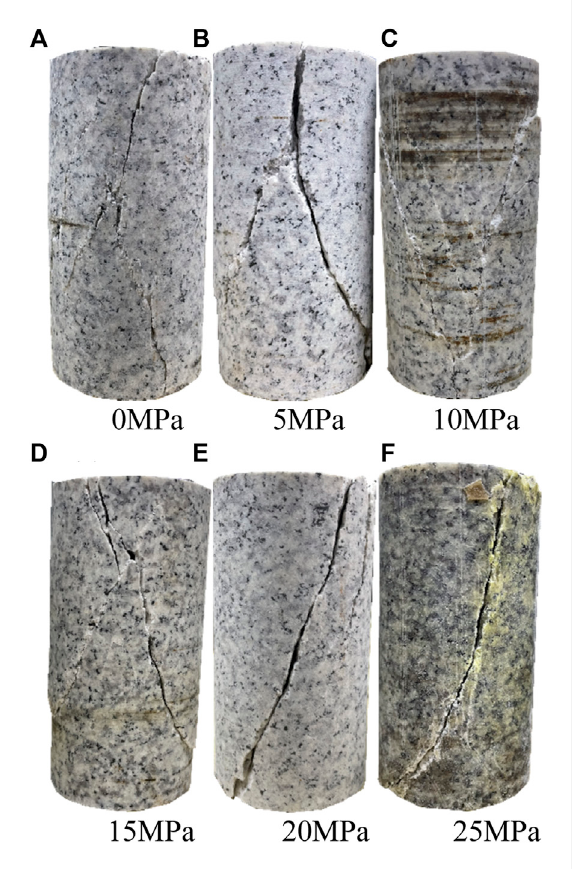
FIGURE 2 Typical failure modes of samples. (A) 0 MPa (B) 5 MPa